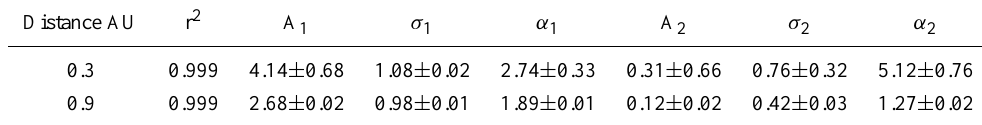
Table 5. Slow Wind: Values of the parameters obtained from the fit of the PDF relative to angular fluctuations. Distance